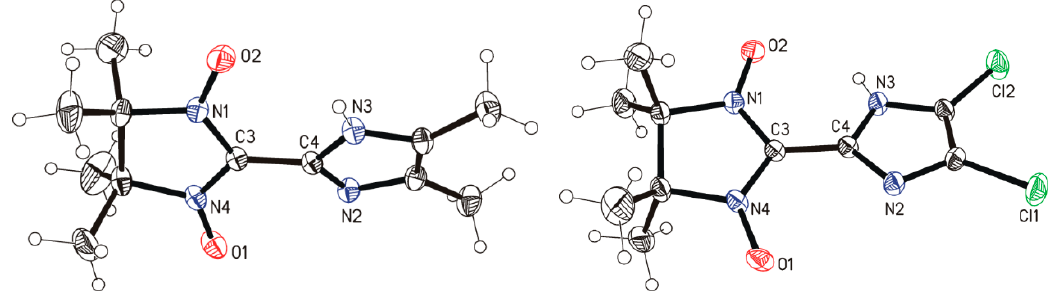
Figure 1. Molecular structures of 1a and 1b (ellipsoids of thermal oscillations at 30%